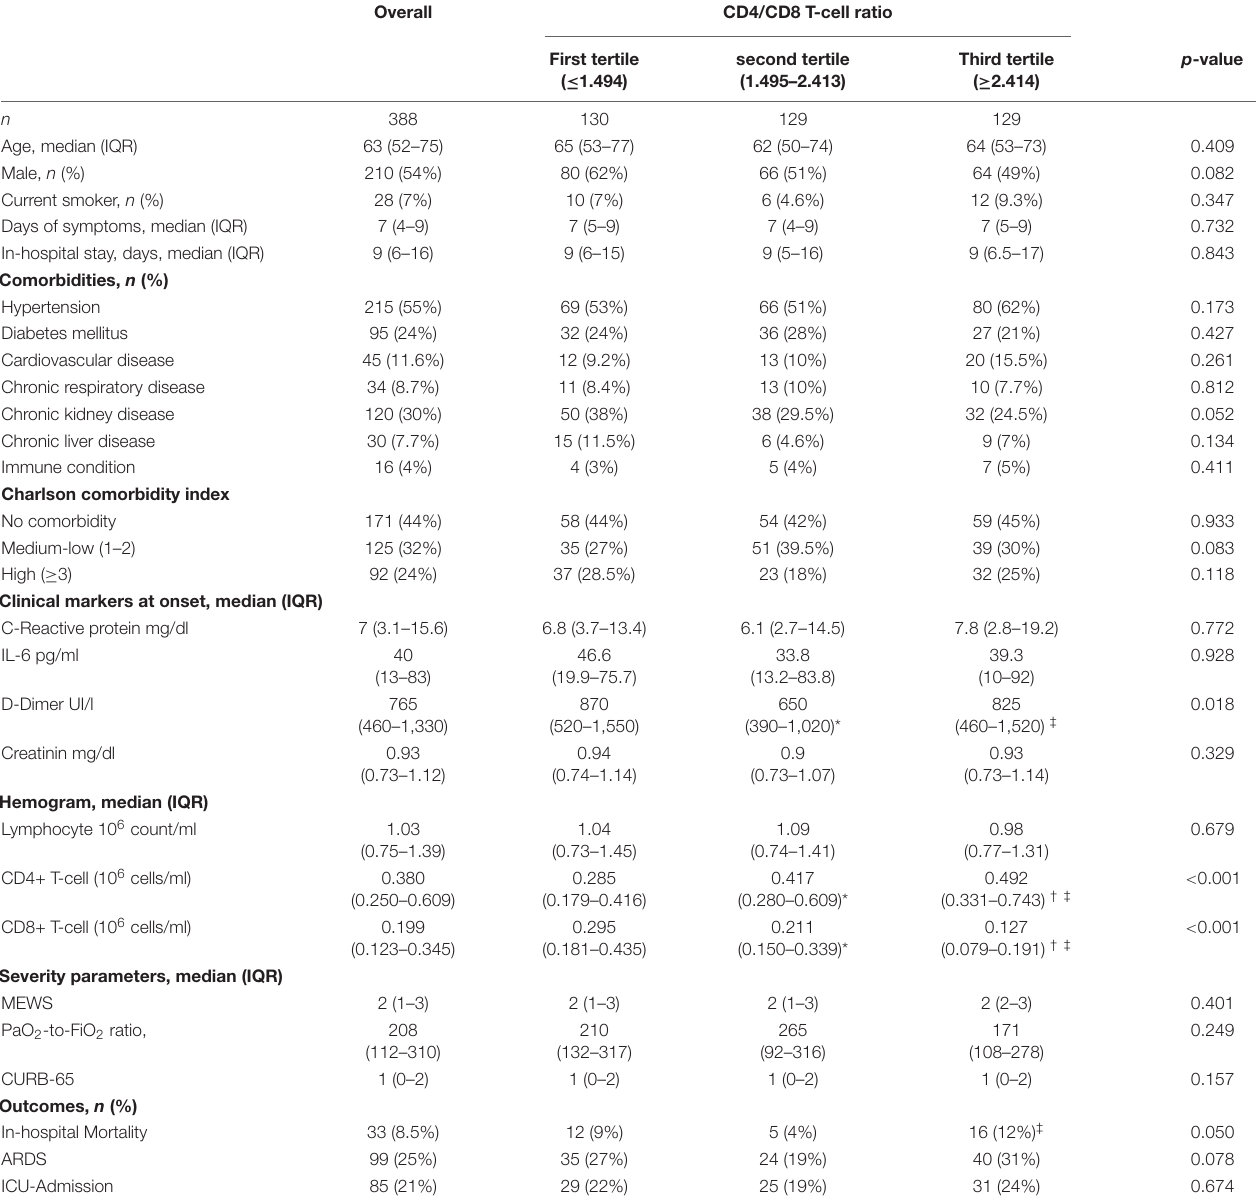
TABLE 1 | Baseline characteristics and the comparison according to the three different CD4/CD8 T-cell ratio tertiles.